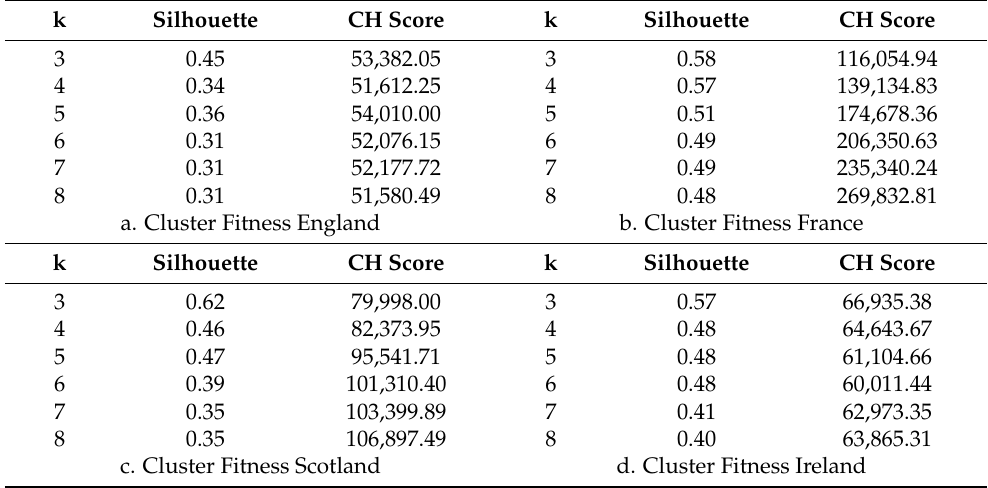
Table 11. Cluster fitness score for countries.